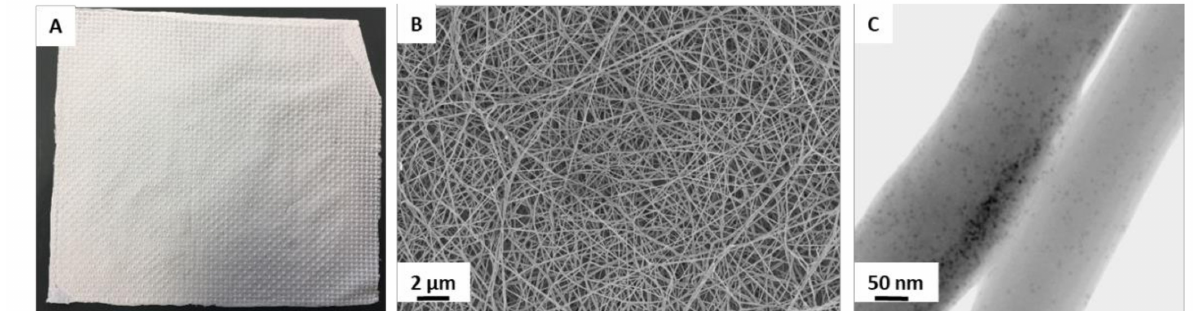
Figure 1. Macroscopic and microscopic pictures of a PDLLA fleece made by electro spinning as an example for a tissue- engineered biomaterial for growth factor delivery. ( A ) Macroscopic photo of a polylactide fleece made by electro spinning. ( B ) SEM image reveals typical non-woven, fibrous structure with random orientation. ( C ) TEM image shows iron containing ferritin molecules adsorbed on the fiber surface. (unpublished results from symposium presentation